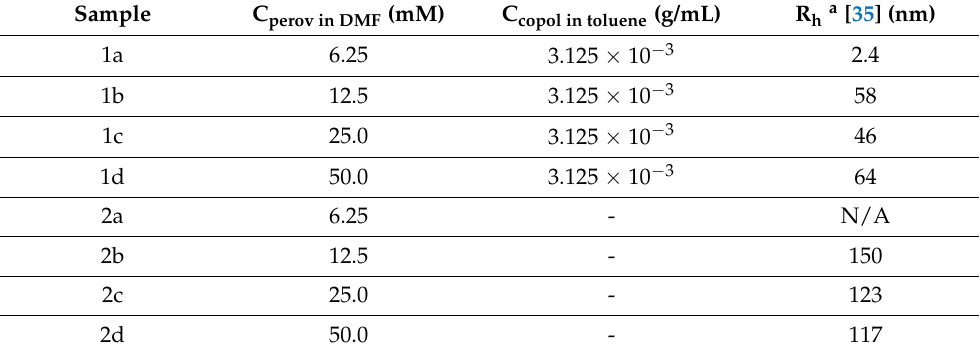
Table 1. Dynamic light scattering results for solution 1a, 1b, 1c, 1d, on the day they were